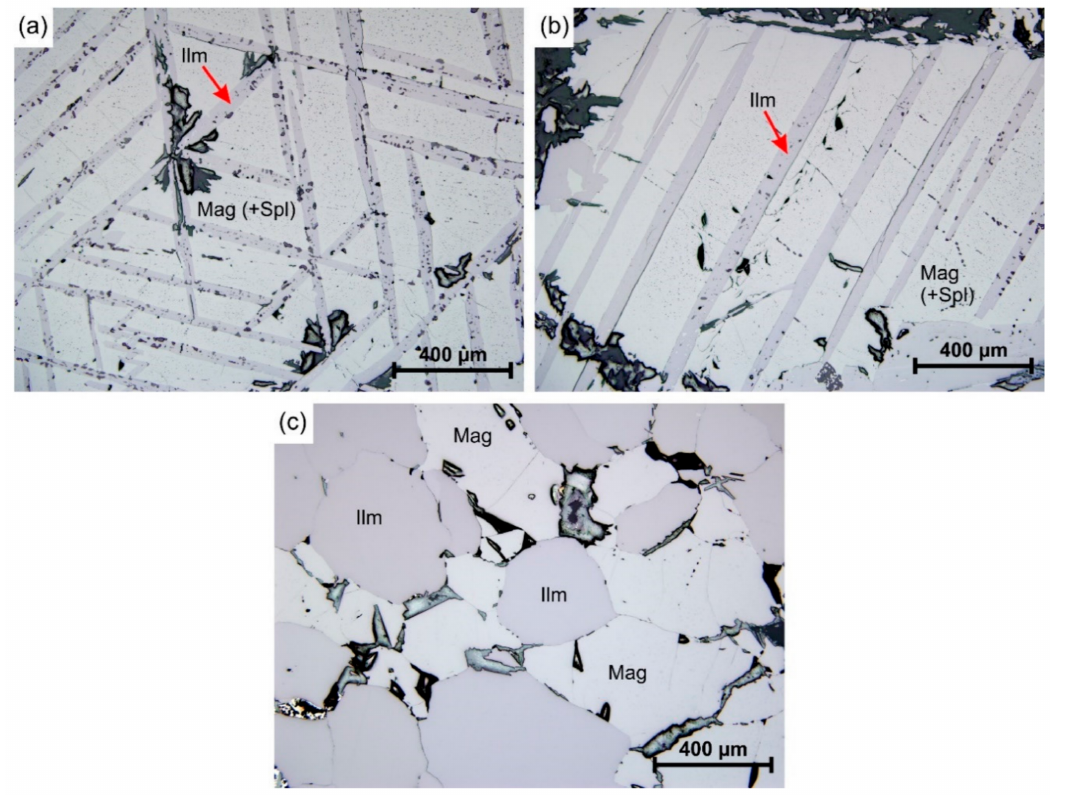
Figure 4. Optical microphotographs showing: ( a ) trellis-type lamellae of Ilmenite-E1 parallel to three sets of {111} lattice planes of the magnetite structure; ( b ) sandwich-type lamellae of Ilmenite-E1 along one set of {111} planes; ( c ) a recrystallized assemblage of magnetite and ilmenite that is characterized by size-reduced grains with a polygonal structure and well-developed triple junctions; note the absence of internal exsolutions of ilmenite in the magnetite. The sample shown in the microphotograph ( c ) has been collected from the immediate vicinity of a shear zone. Ilm, ilmenite; Mag, magnetite; Spl,